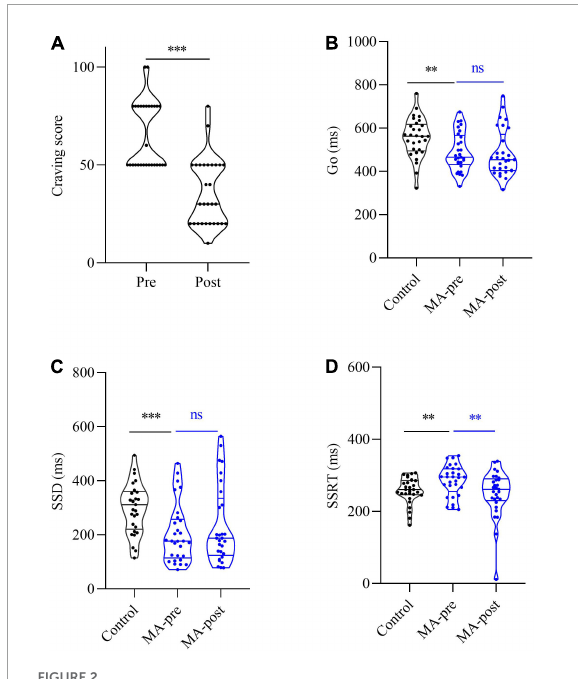
FIGURE2 Comparison craving score between the experimental group of pre- and post-test. (A) The pre-test was significantly higher than the post-test score of the experimental group [ t (28) = 7.33, p < 0.001] of patients with MAUD. Comparison of SST and NoGo between experimental and control groups. (B) For Go, the pre-test of the experimental group was significantly lower than the score of the control group [ t (56) = 3.31, p < 0.01], and the post-test of the experimental group was also significantly lower than the score of the control group [ t (56) = 3.21, p < 0.01]. No significant difference was found between the pre-test and the post-test scores of the experimental group [ t (28) = 0.71, p = 0.49]. (C) For SSD, the pre-test of the experimental group was significantly lower than the score of the control group [ t (56) = 3.68, p < 0.001], and the post-test of the experimental group was also significantly lower than the score of the control group [ t (56) = 2.32, p < 0.05]. No significant difference was found between the pre-test and the post-test scores of the experimental group. (D) For SSRT, the pre-test of the experimental group was significantly higher than the score of the control group [ t (56) = 2.38, p < 0.05]. There was no significant difference between the post-test of the experimental group and the score of the control group [ t (56) = 0.54, p > 0.05]. The pre-test was significantly higher than the